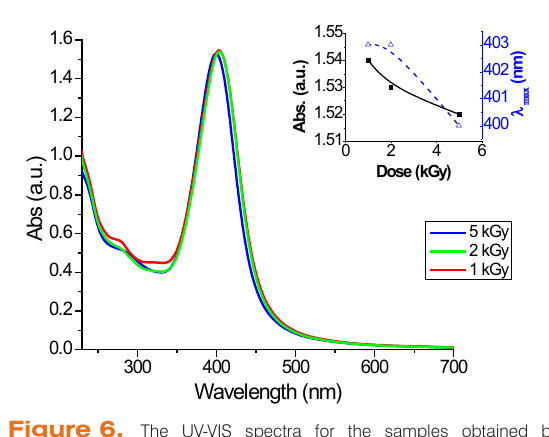
Figure 6. The UV-VIS spectra for the samples obtained by irradiation at low dose rate and IPA-TA-PVA composition. Inset: the effect of radiation dose on the absorption peak characteristics.